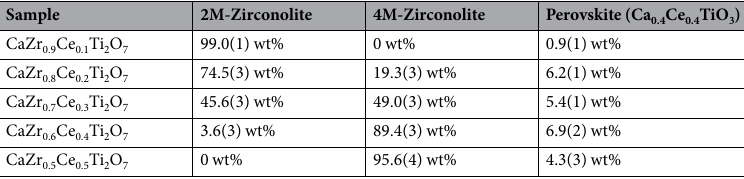
Table 3. Percentages of phases present in zirconolite powder samples synthesized via solid-state sintering determined by Rietveld